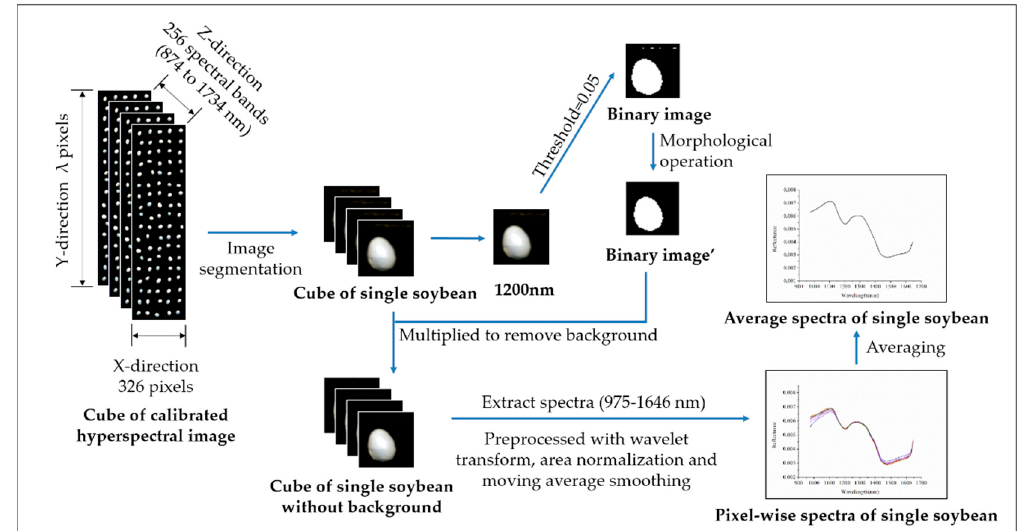
Figure 2. Procedures of spectral data extraction and preprocessing.